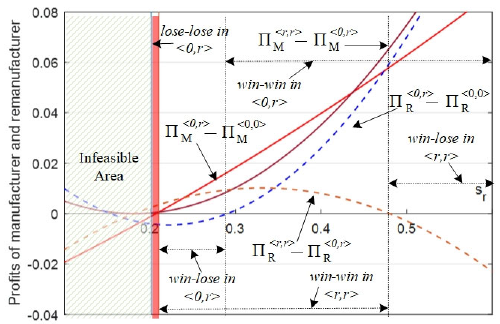
Figure 9. Dilemma for the remanufacturer in < 0 , r > and < r , r >